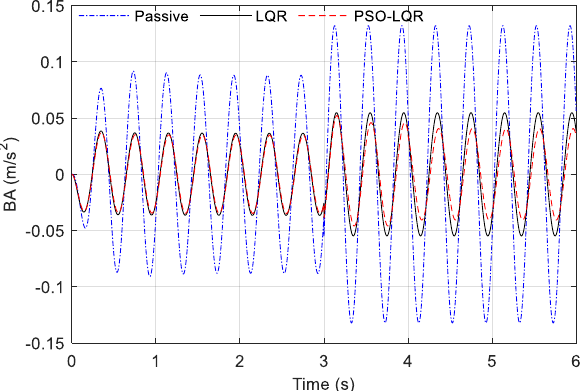
Figure 15. Comparison of mode switching control tests under sinusoidal excitation. Table 7. RMS comparison of BA of three groups of test data.